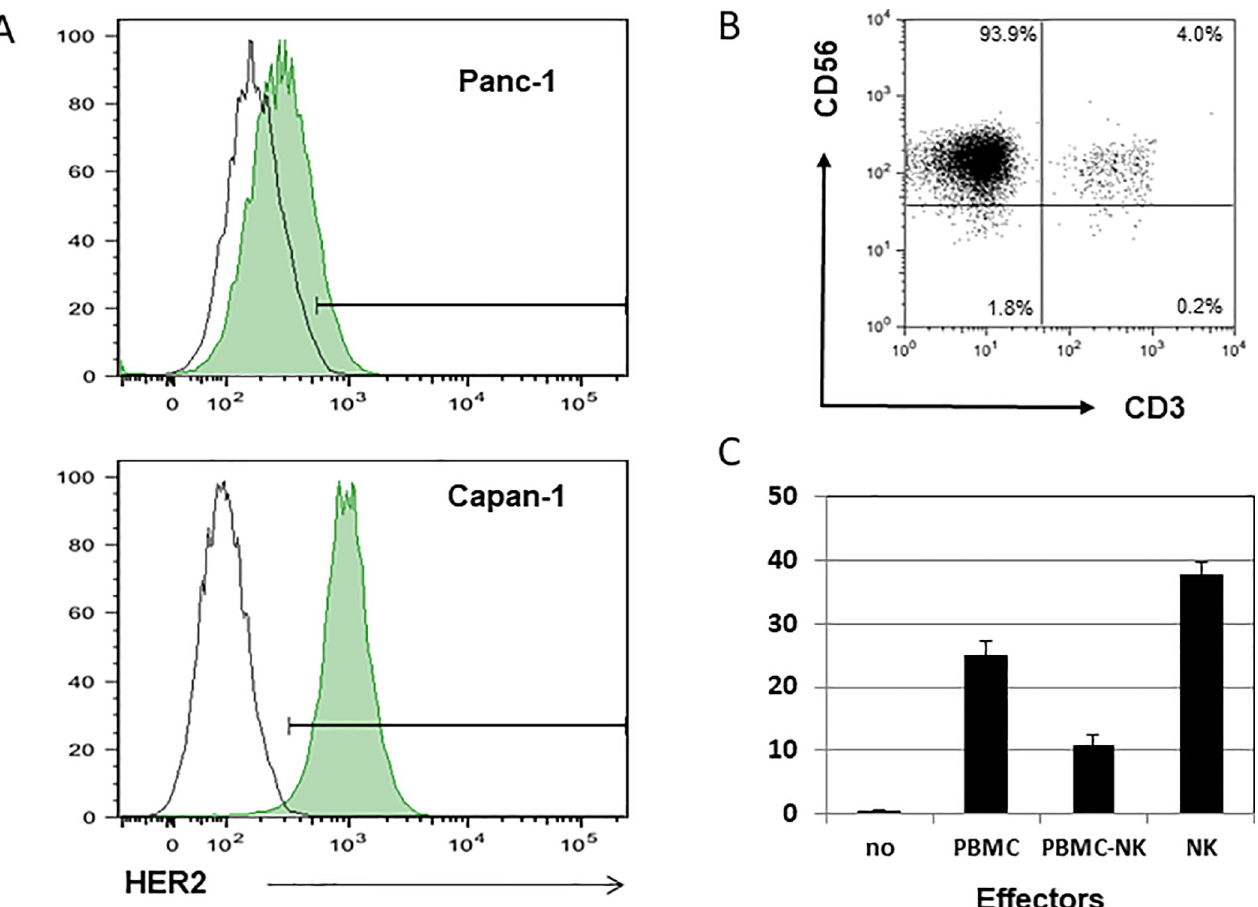
Fig 1. A: Flow cytometric analysis was performed to confirm HER2 expression on Panc-1 (upper panel) and Capan-1 (lower panel). B: The isolated NKs cell were confirmed to be CD3 negative and CD56 positive by flow cytometry. C: The fundamental viability of the isolated NK cells was evaluated as cytotoxicity against the NK-sensitive thymoma cell line